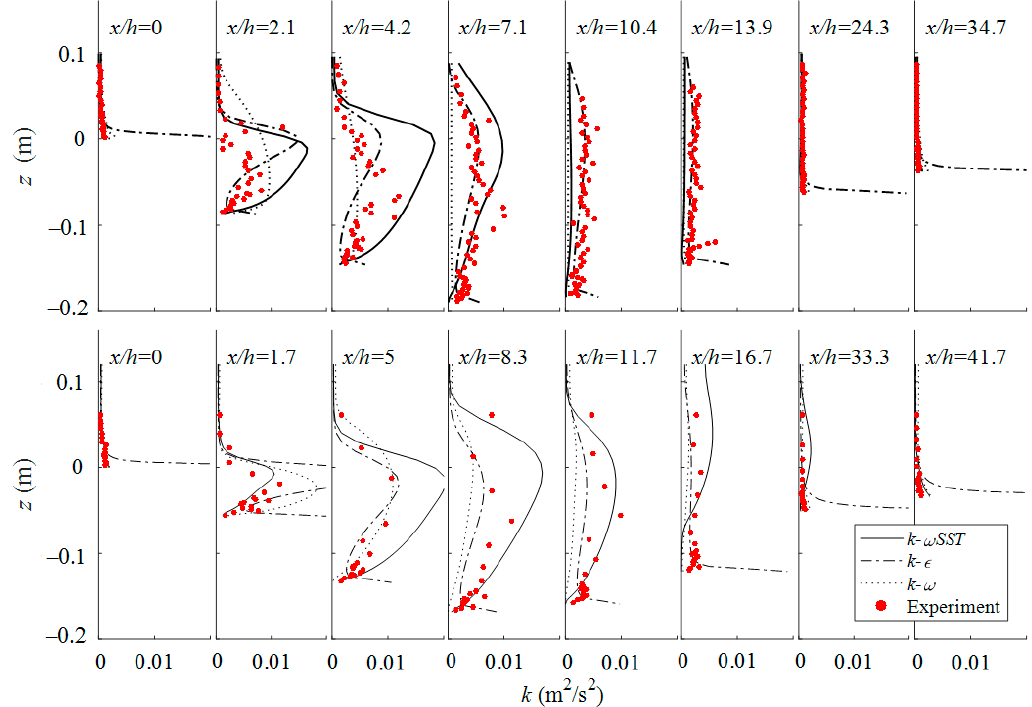
Figure 7. Turbulence kinetic energy along the channel with respect to turbulence models along with the experimental data for Case Exp1 ( above ) and Case Exp2 ( below ).